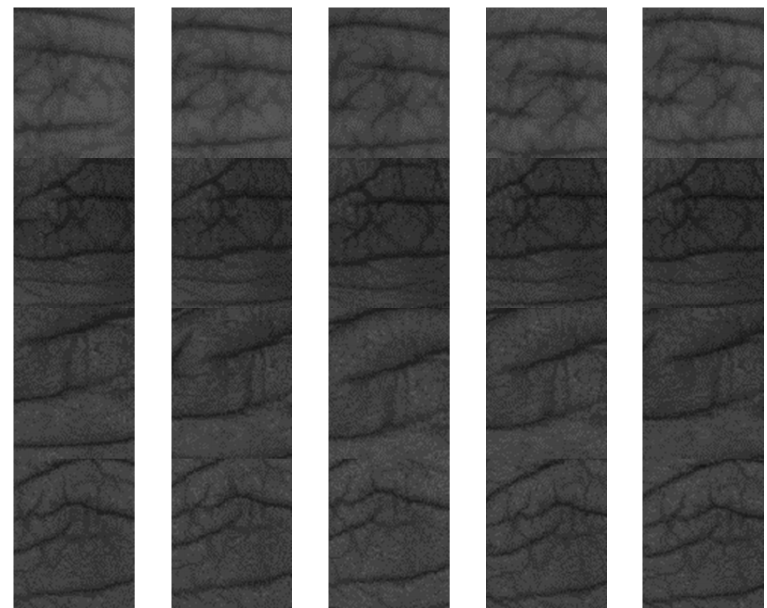
Figure 1. Sample from the IIT Delhi Finger Knuckle Dataset [138].